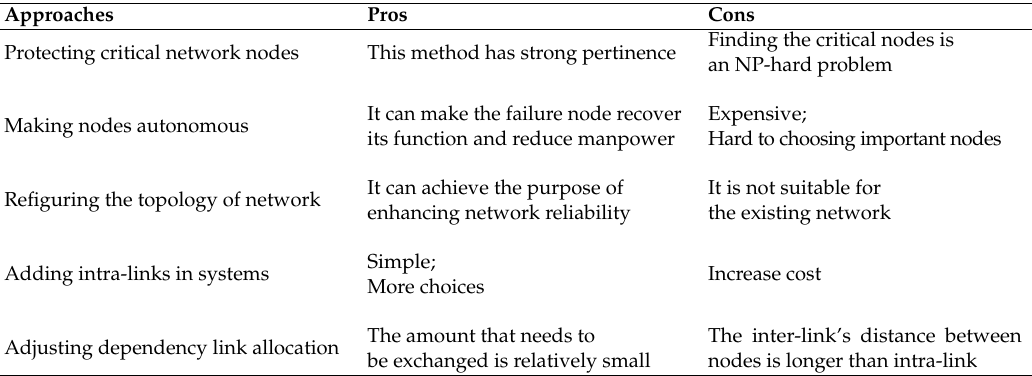
Table 1. Approaches in interdependent